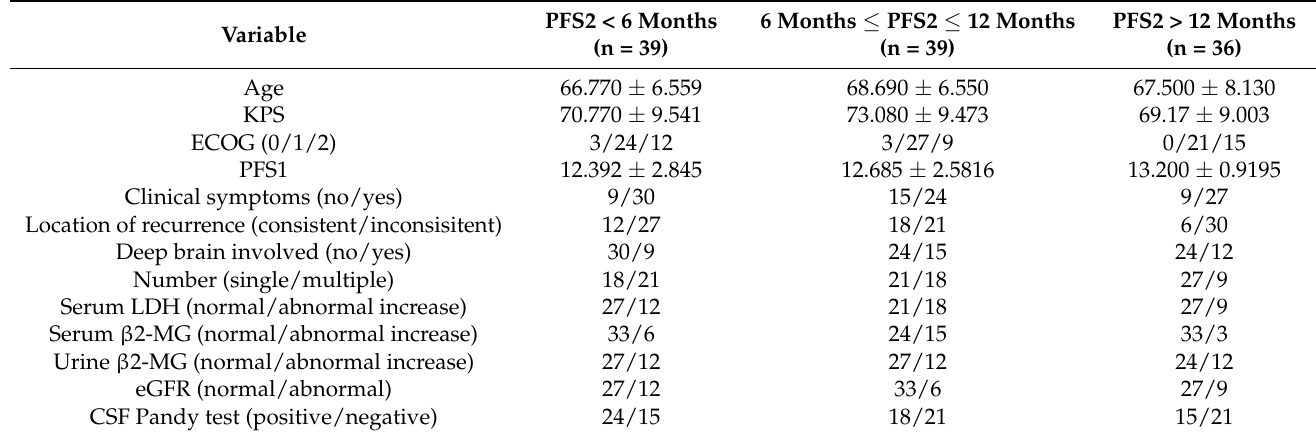
Table 2. Summary of clinical characteristics by PFS2